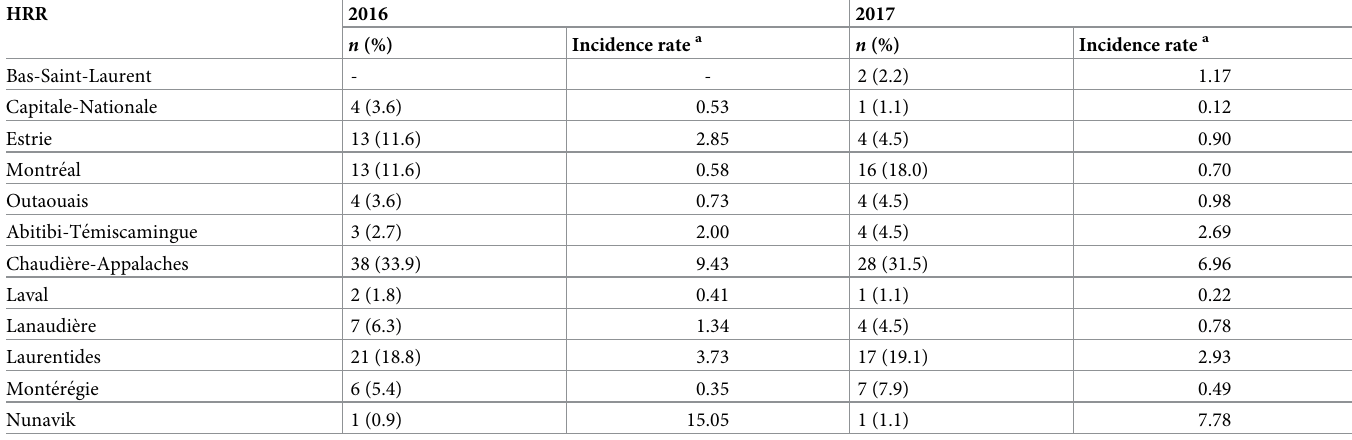
Table 1. Number, percentage and sex and age-adjusted incidence rate of confirmed reported cases by health region of residence (HRR) in Que´bec, Canada, 2016– 2017. HRR